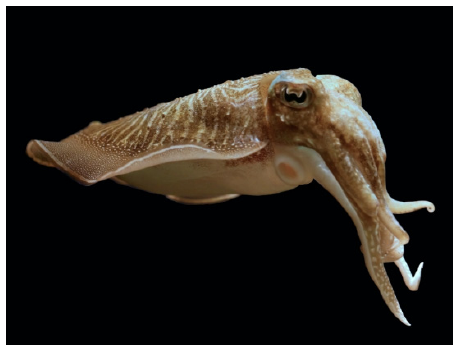
Figure 17. A specimen of Sepia officinalis . © Hans Hillewaert (CC BY-SA 4.0); http://www.marinespecies.org/.